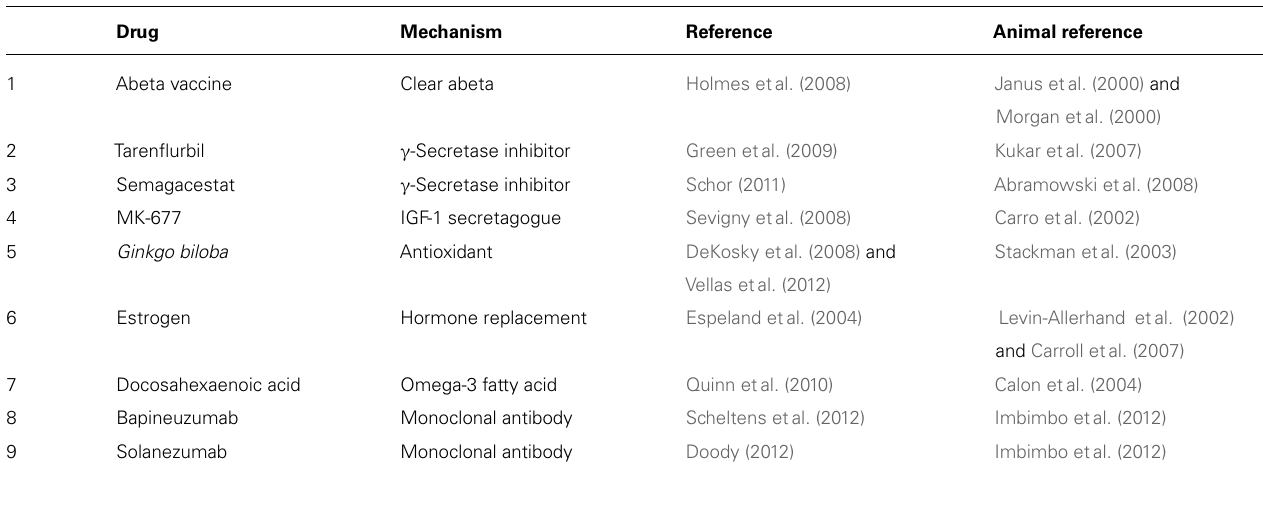
Table 1 | Failed phase III trials of agents which were effective in transgenic mouse models.